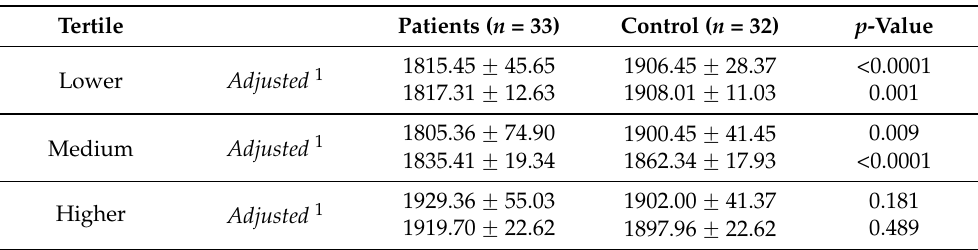
Table 6. QUS figures based in the calcium intake tertile and between groups.